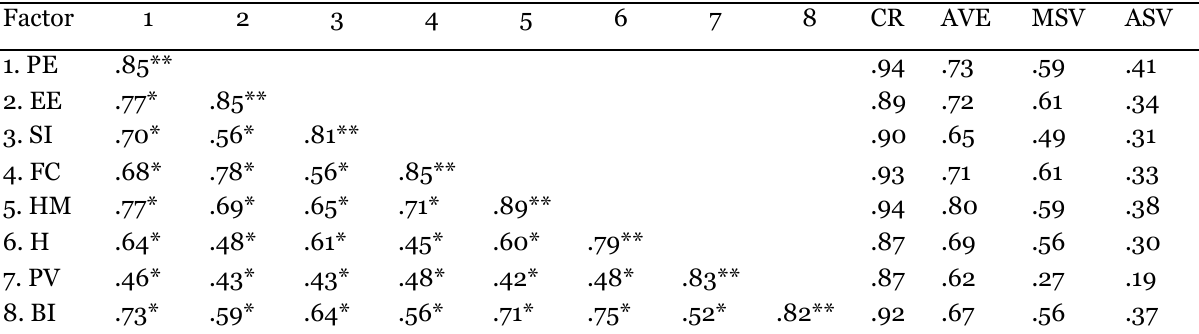
Results of Convergent, Discriminant, and Nomological Validity Analysis